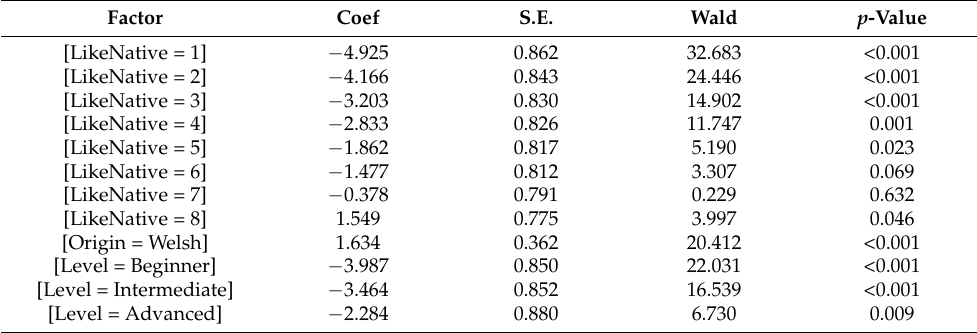
Table A4. Coefficients for My pronunciation in Welsh is like a ‘native’ speaker’s.